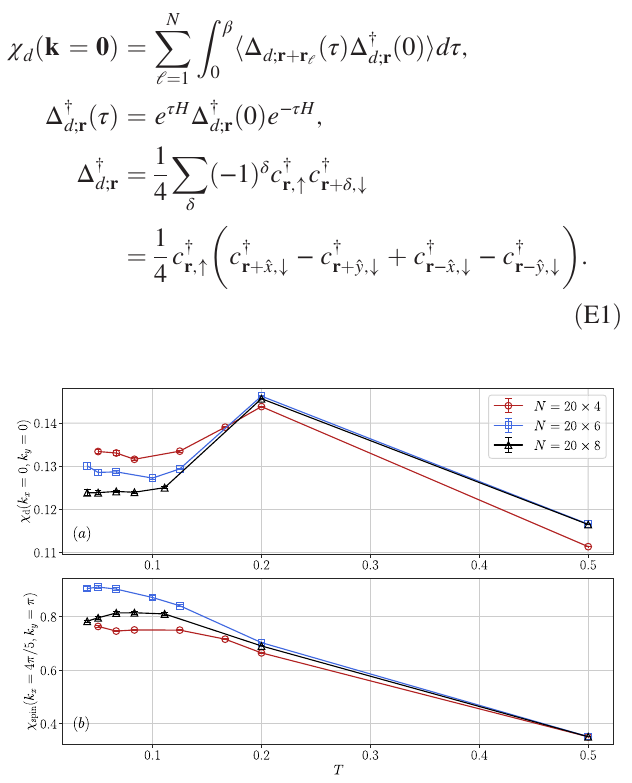
FIG. 13. (a) The d -wave pairing susceptibility χ d ð k Þ plotted at k ¼ ð 0 ; 0 Þ , as a function of temperature T for three different supercell sizes. (b) The corresponding spin susceptibility χ plotted at the characteristic wave vector for incommensurate SDW. The system has U=t ¼ 6 and δ ¼ 1 = 5 .